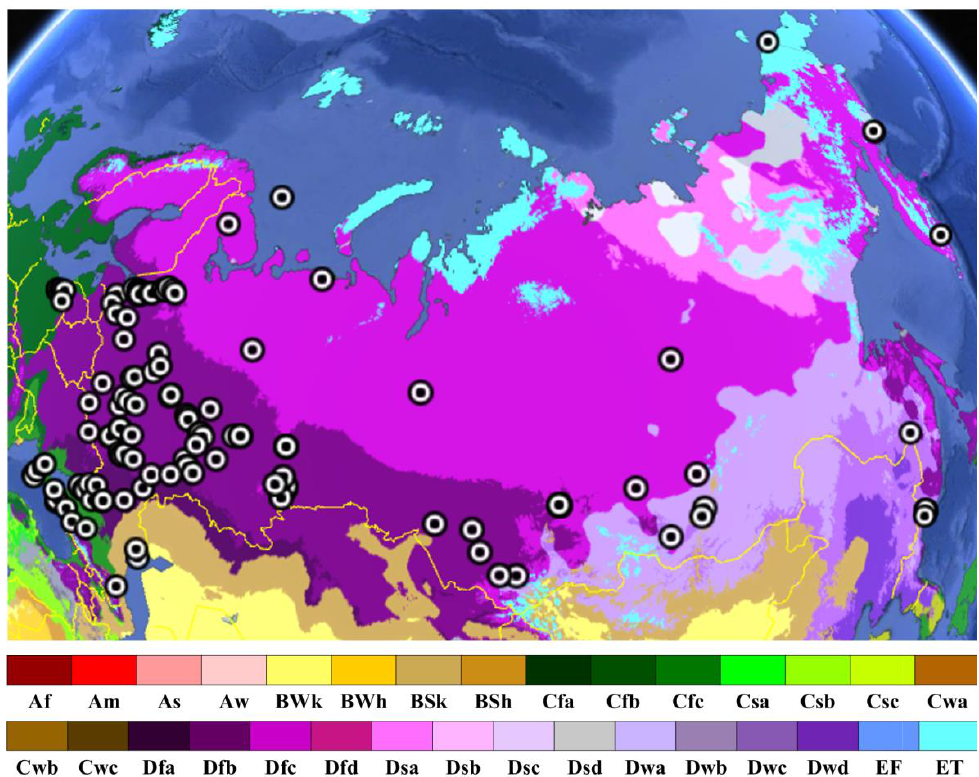
Figure 1. The map of the geographical distribution of algal bloom outbreaks in Russia. The map was created using Google Earth Pro software [39], Cyanohab.ru data for algal bloom outbreaks (black and white circles) and Köppen-Geiger climate map [37,38]. The legend below shows the types of the climate zones [38]. Climate zones with the first letter “E” in the abbreviation represent polar climate, “D” represent boreal climate, “C” represent warm temperate climate, “B” represent arid climate. More information about types of the climate zones is available at http://koeppen-geiger.vu-wien.ac.at/present.htm [37].